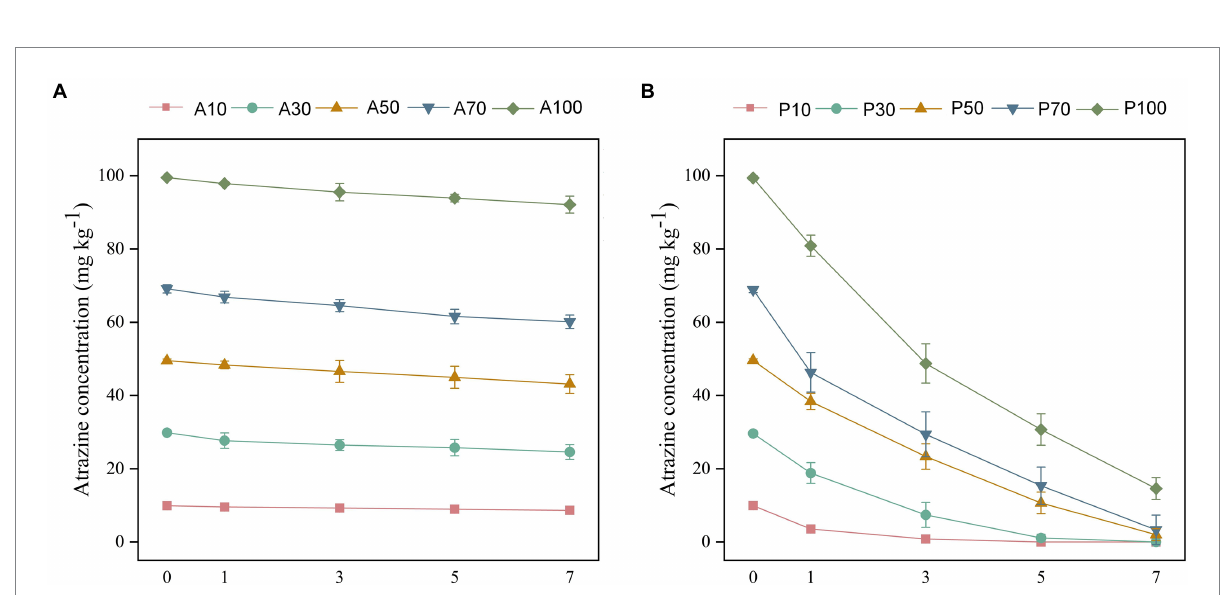
FIGURE 4 The concentrations of atrazine residues without P. ureafaciens ZY inoculation (A) and with P. ureafaciens ZY inoculation (B) treatments after 7 days. A10: 10 mg kg − 1 atrazine-contaminated soil; A30: 30 mg kg − 1 atrazine-contaminated soil; A50: 50 mg kg − 1 atrazine-contaminated soil; A70: 70 mg kg − 1 atrazine-contaminated soil; A100: 100 mg kg − 1 atrazine-contaminated soil; P10: 10 mg kg − 1 atrazine-contaminated soil with P. ureafaciens ZY inoculation; P30: 30 mg kg − 1 atrazine-contaminated soil with P. ureafaciens ZY inoculation; P50: 50 mg kg − 1 atrazine-contaminated soil with P. ureafaciens ZY inoculation; P70: 70 mg kg − 1 atrazine-contaminated soil with P. ureafaciens ZY inoculation; P100: 100 mg kg − 1 atrazine- contaminated soil with P. ureafaciens ZY